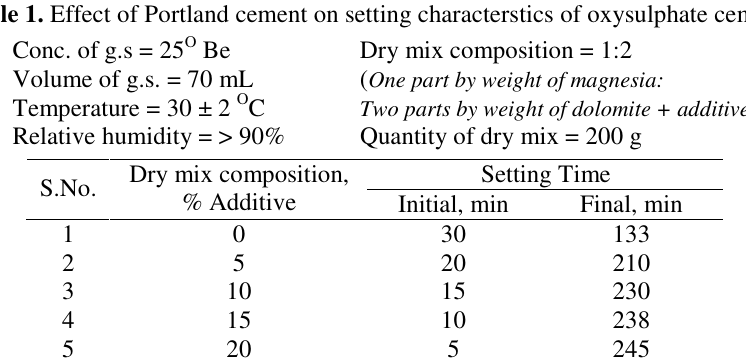
Table 1. Effect of Portland cement on setting characterstics of oxysulphate cement.